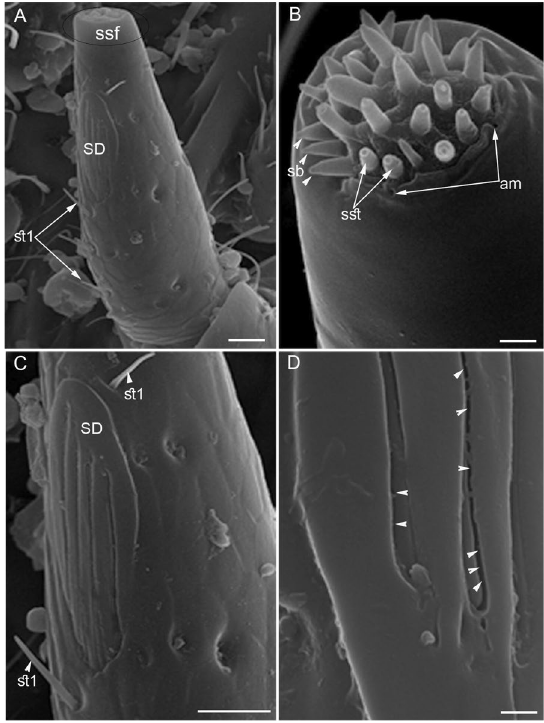
Fig. 6 Scanning electron micrographs (SEM) of close up view of the distal segment of the maxillary palp of adult Rhyzopertha dominica and their associated sense organs. A Distal segment of the maxillary palp with numerous short s. trichodea (st1) and single large s. digitiformium (SD), note that the apical tip of the palp carry an apical sensory field (ssf); scale bar 10 µm. B Enlarged view of = the apical part of the maxillary palp carried s. styloconica (sst), s. basiconica (sb) and s. ampullacea. Scale bar 2 µm. C Close up view = of s. digitiformium showing longitudinal gutters. Scale bar 10 µm. D = enlarged view of the base of s. digitiformium showing internal pores inside the longitudinal gutters (arrow heads). Scale bars: A 10 µm; B 2 µm; C 10 µm; D 1